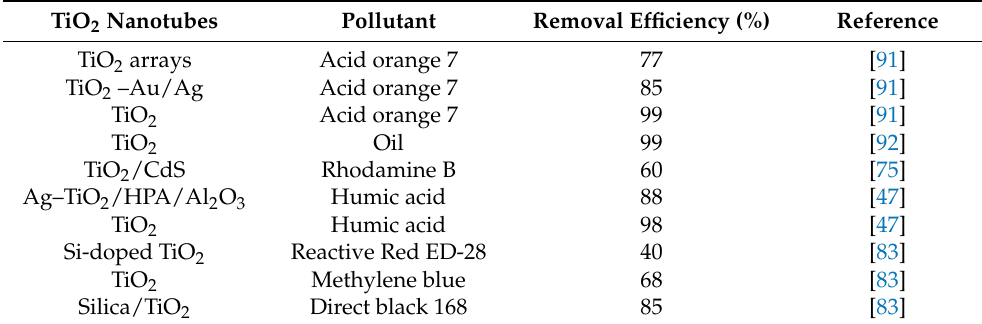
Table 3. Removal of pollutants using TiO 2 nanotubes.